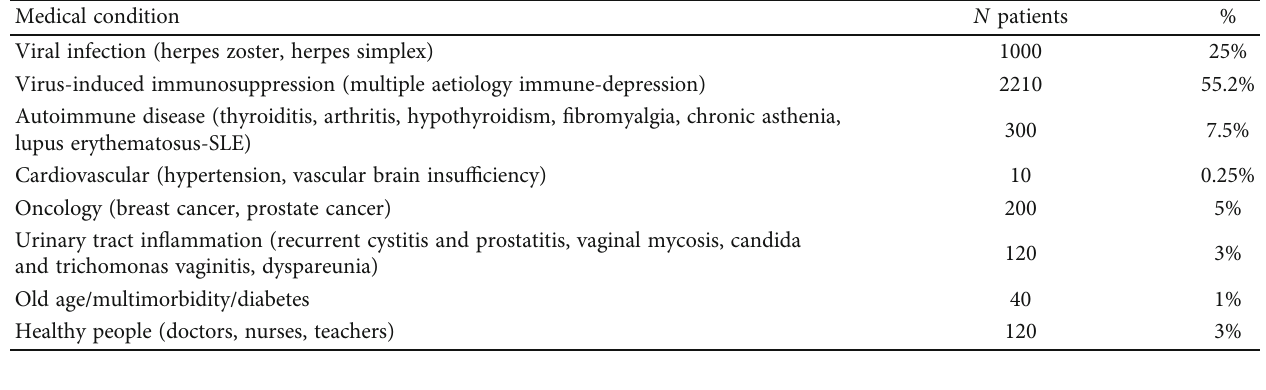
Table 2: Clinical-pathologic background of the treated cohort. Considering the nonnormal distribution, nonparametric statistics were used to compare the disease population. All descriptive data were reported in percentages